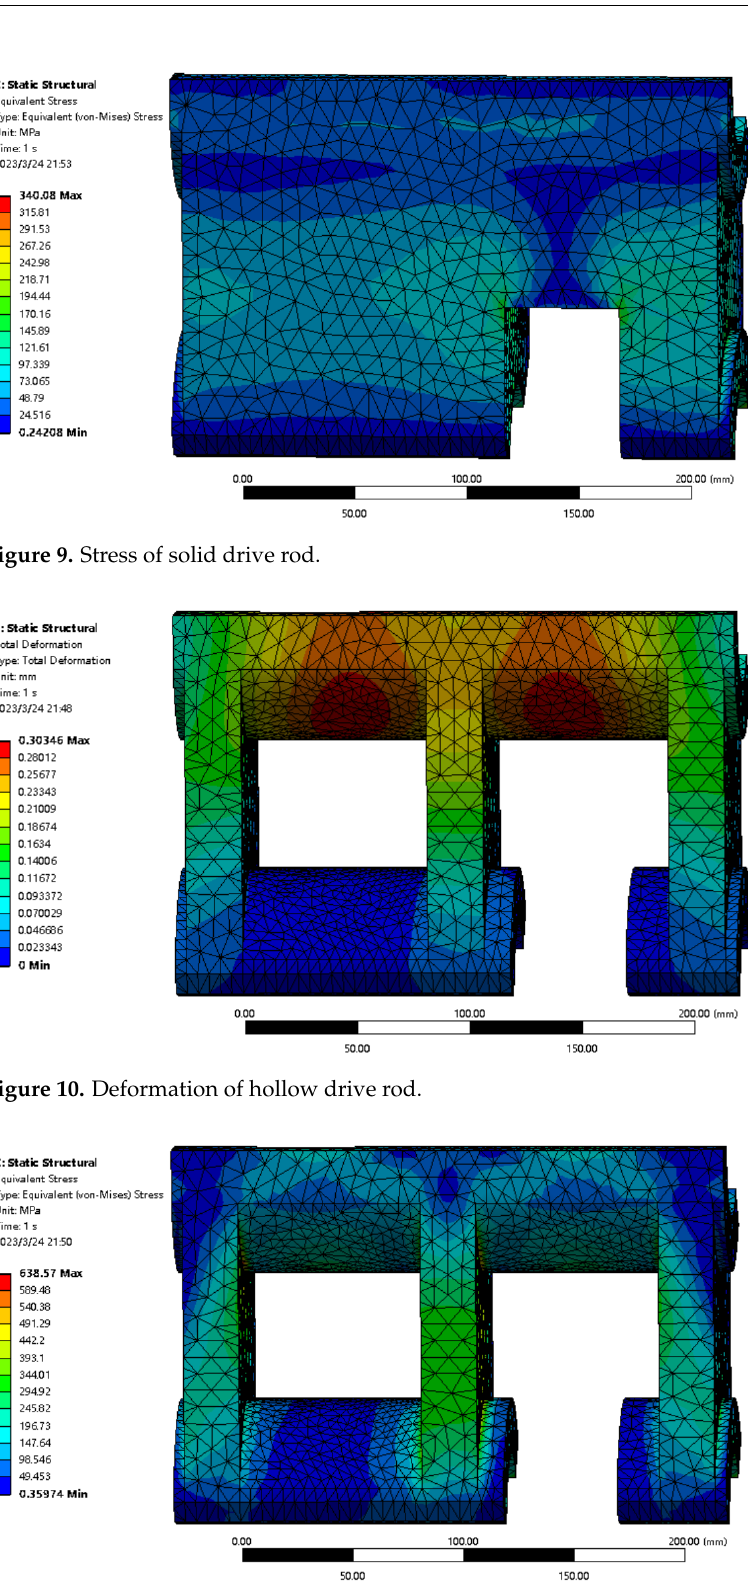
Figure 8. Deformation of solid drive rod.